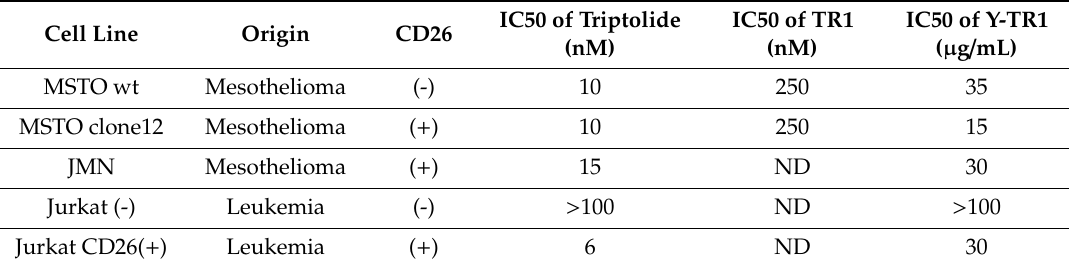
Table 1. IC50 of Triptolide, TR1 and Y-TR1 against MM and leukemia cell